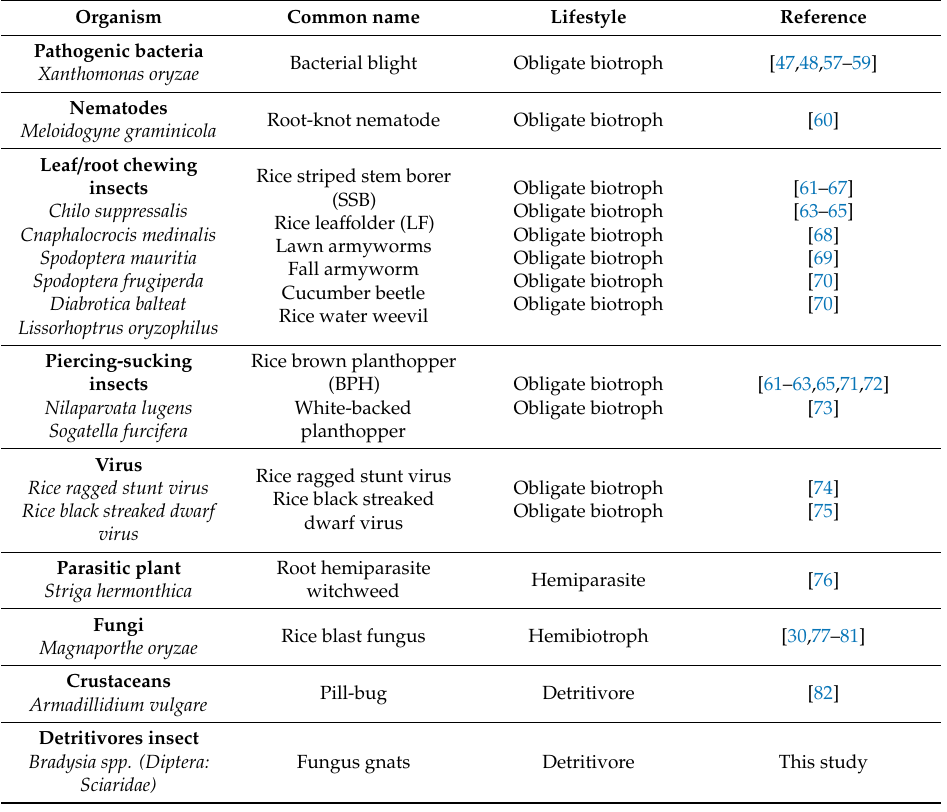
Table 1. Rice pathogens and pests whose parasitism is reduced by Jasmonates-triggered